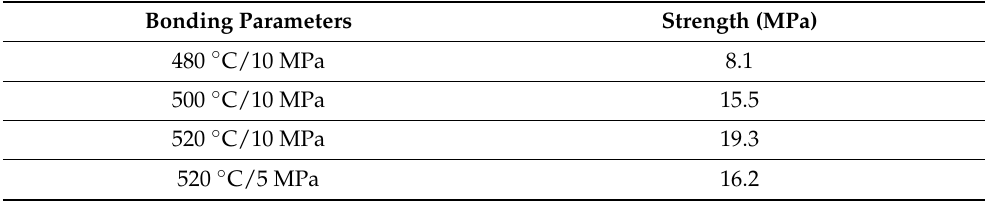
Table 1. The strength of bonds at different